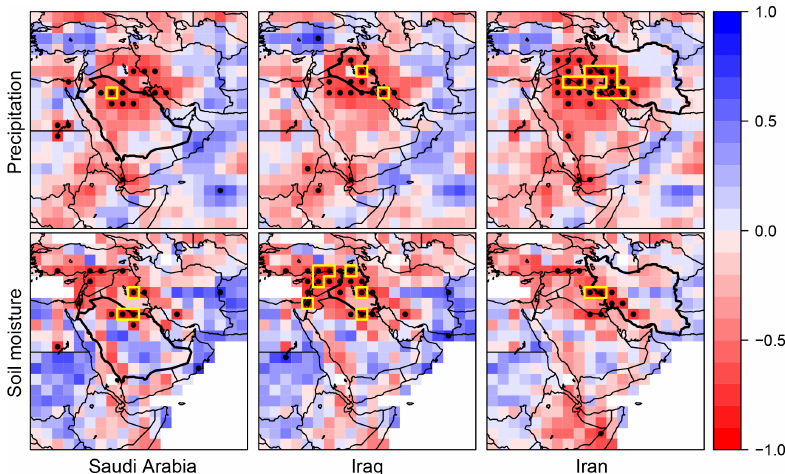
Figure 7. Correlation of precipitation (top row) and soil moisture (bottom row) with the AOD over Saudi Arabia, Iraq and Iran. For soil moisture and AOD, annual averages are used where the averaging period starts with the AOD season on 1 December, for the precipitation the averaging period starts with the precipitation season on 1 September to take effects on vegetation and soils into account. Pixels with significant correlation ( p value < 0.01) are marked with a dot. Pixels with correlation coefficients below − 0.8 are outlined in yellow. MODIS Terra collection 6 combined Dark Target/Deep Blue 550nm AOD data are used, precipitation data are taken from TRMM 3B42, soil moisture from the European Space Agency Climate Change Initiative